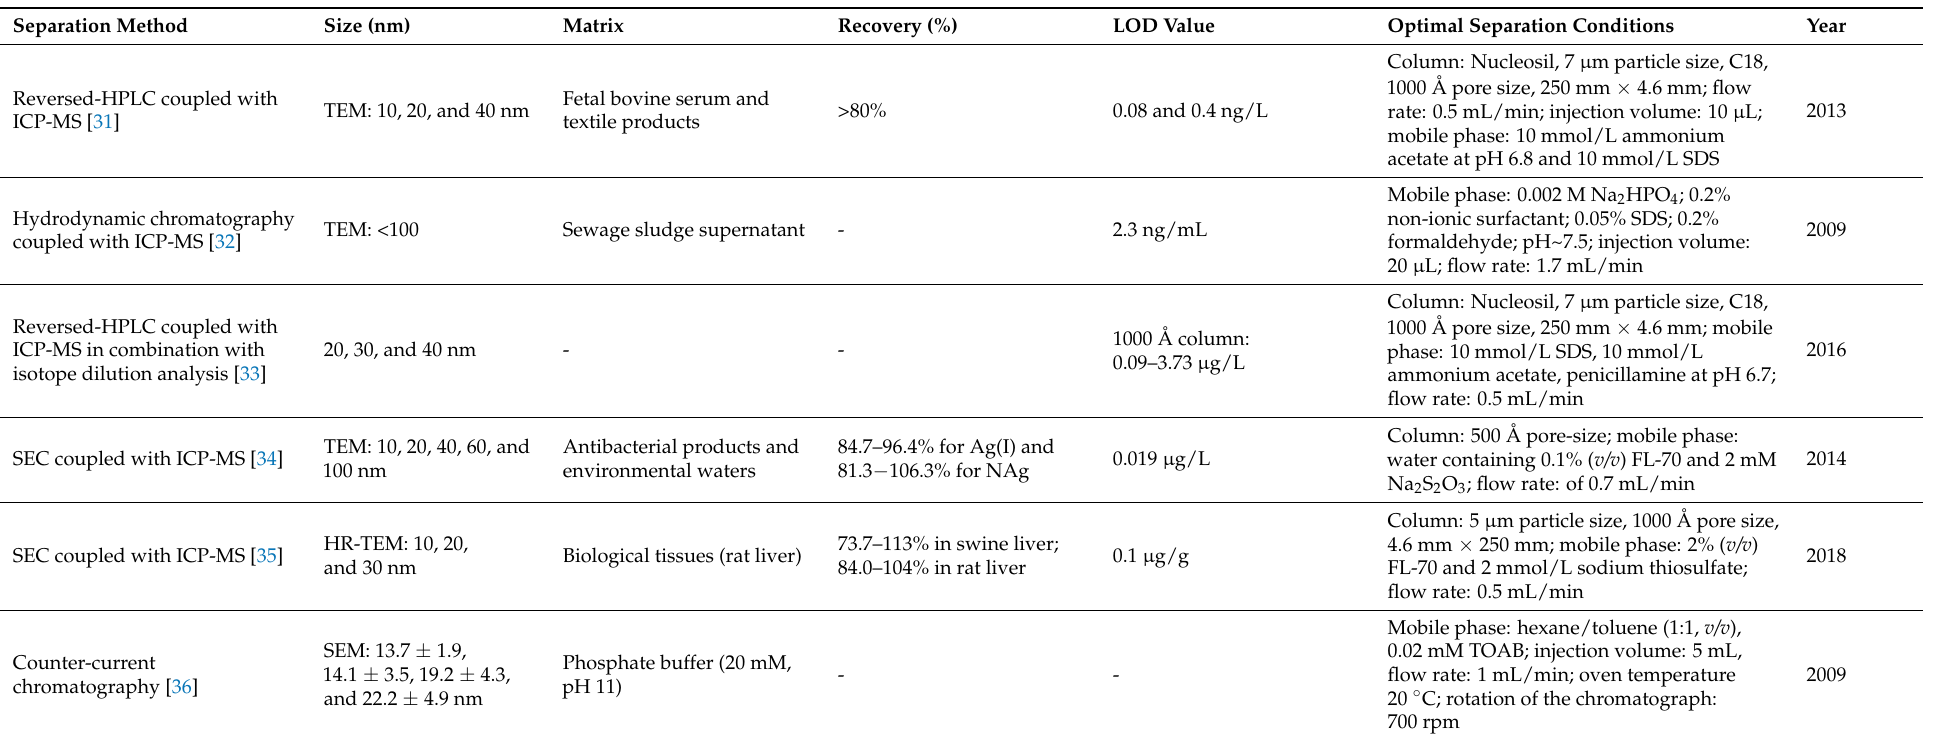
Table 3. Overview of AgNPs separation based on